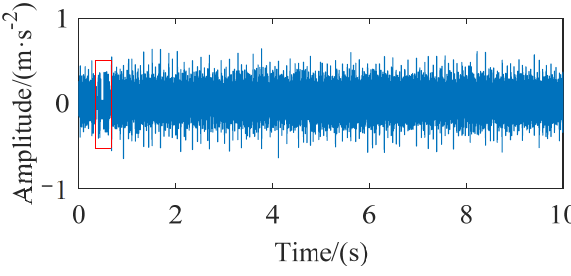
Figure 15. Fan end vibration signal.